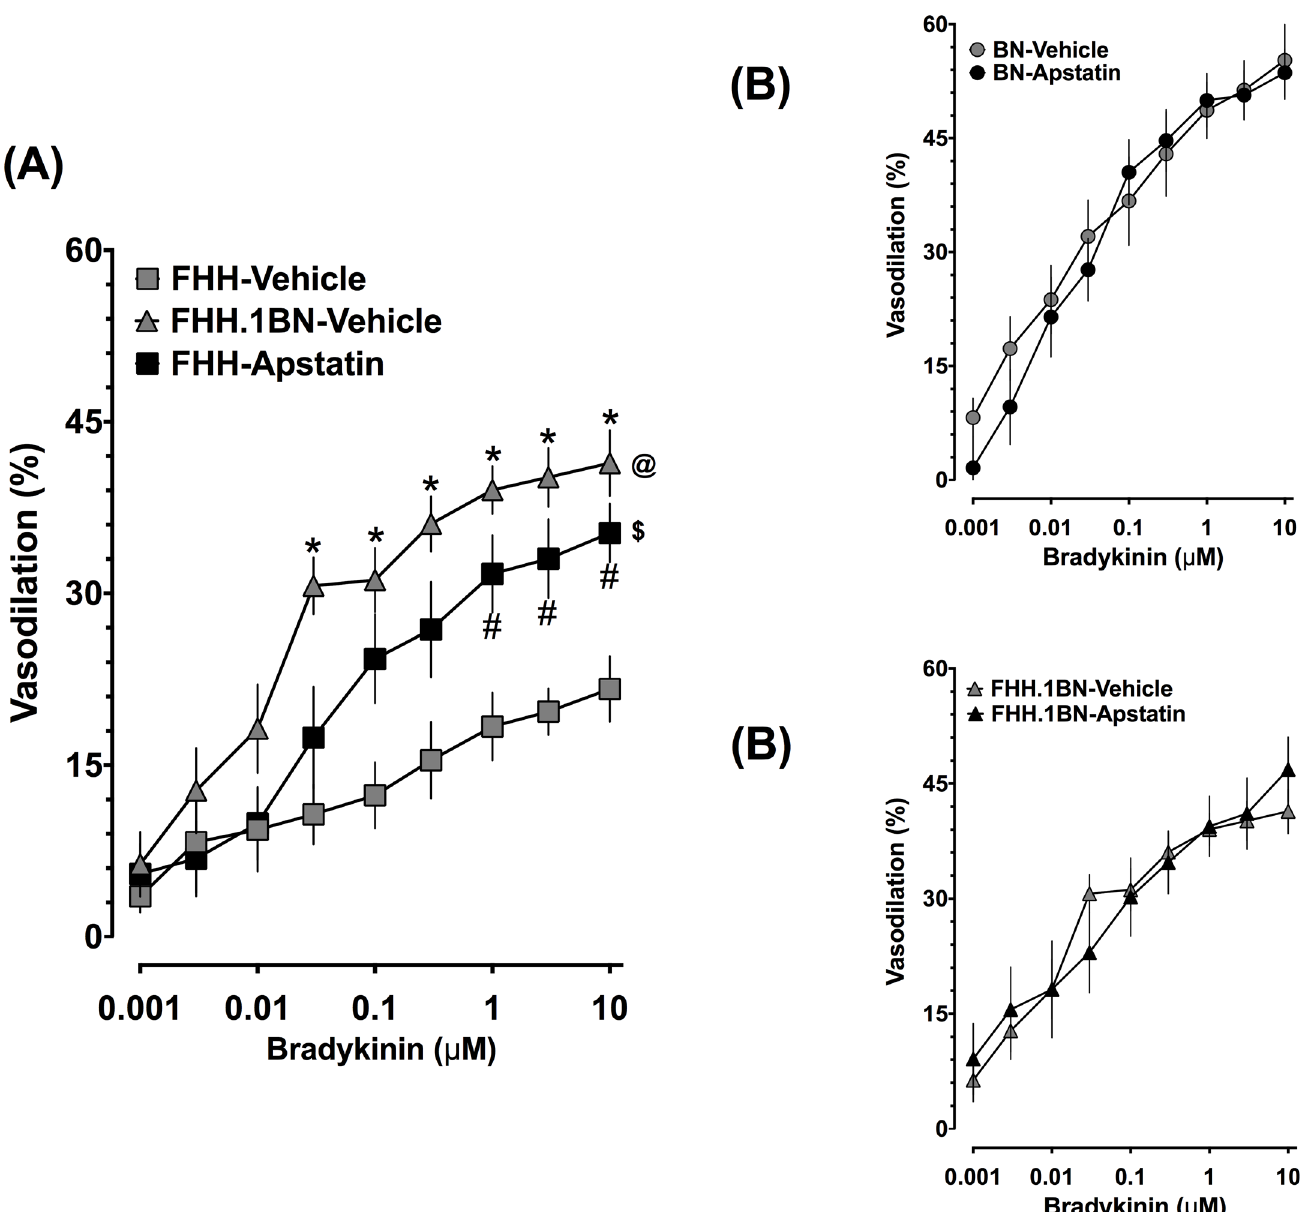
Fig 4. Cerebral arterial responses to bradykinin in the absence and presence of aminopeptidase P inhibition. Cerebral arterial responses to bradykinin in the absence and presence of a specific aminopeptidase P inhibitor, apstatin, in different experimental groups. (A) Apstatin restored cerebral arteriolar responses to bradykinin in FHH rats. * Indicates significant difference from the same concentration of bradykinin between FHH-Vehicle and FHH.1BN-Vehicle. #Indicates significant difference from the same concentration of bradykinin between FHH-Vehicle and FHH-Apstatin. @ and $ Indicate significant difference in the overall bradykinin response in FHH-Vehicle with that in FHH.1BN-Vehicle and FHH-Apstatin, respectively. Cerebral arteriolar bradykinin responses in BN (B) and FHH.1BN (C) rats were not affected by apastatin. A value of P < 0.05 was considered statistically significant. Values are presented as mean ± S.E.M., n =